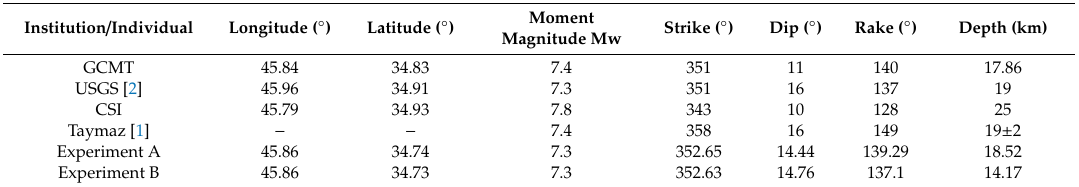
Table 2. Fault geometric parameters from nonlinear optimizations assuming uniform slip (this study and earlier